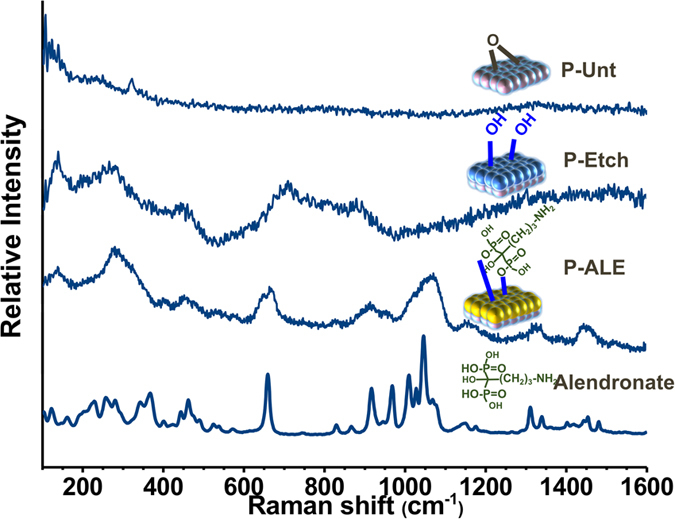
Raman spectra of P-Unt, P-Etch and P-Ale substrates.The scan for pristine alendronate drug from commercial source is included for reference.